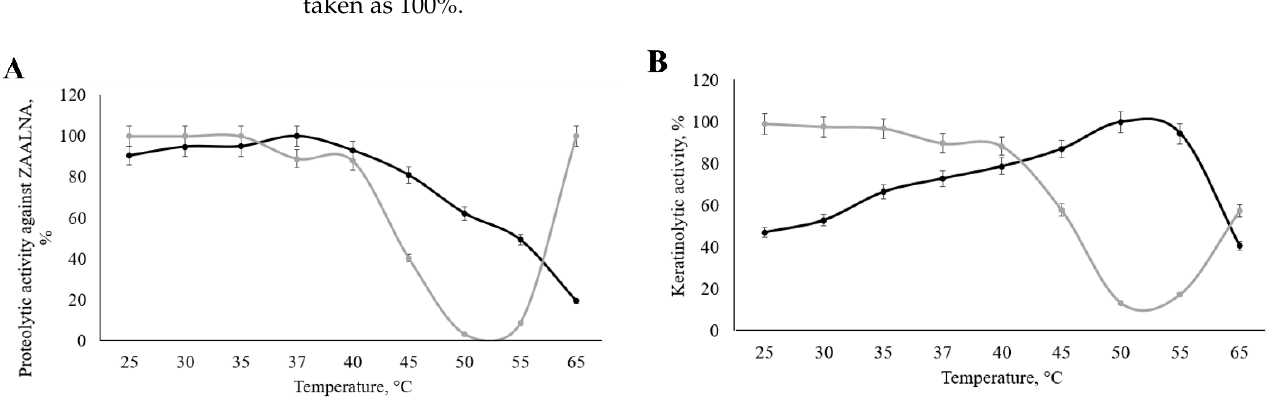
Figure 10. Activity of the Aspergillus clavatus VKPM F-1593 keratinase against ZAALNA ( A ) and keratin ( B ) dependency on temperature: T-optimum (black lines); T-stability (grey lines).